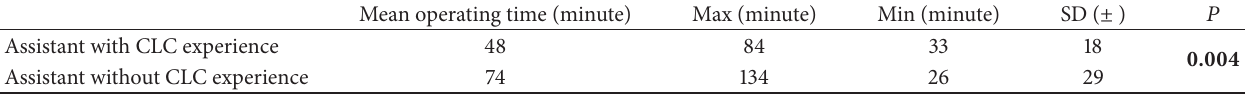
Table 5: Mean operating time of cases assisted by assistants with and without CLC